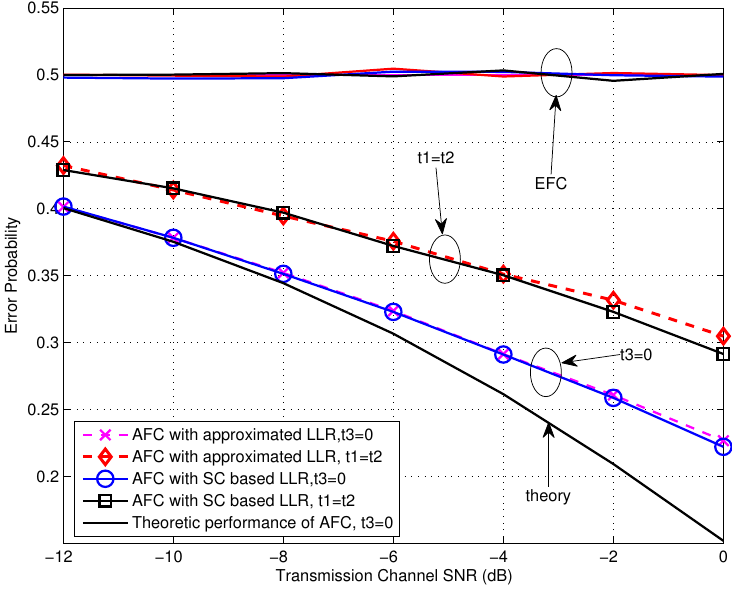
Figure 4. Error probabilities at the AFC and EFC as functions of various SNR for β = 0.8 and snr L = 5 dB over low SNR